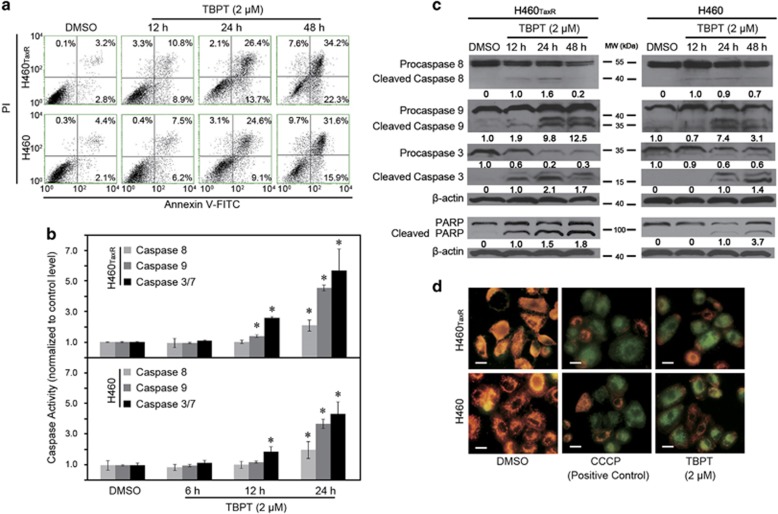
TBPT induces time-dependent apoptosis in both H460TaxR and H460 cells. (a) The cells were treated with DMSO or TBPT (2 μM), stained with PI/Annexin V-FITC, and analyzed using flow cytometry. (b) The activities of caspases 8, 9 and 3/7 were examined using a fluorescence-based assay. *Student's t-test with the DMSO group, P<0.05, N=3. (c) Western blot analysis of caspases 8, 9, 3 and PARP after TBPT treatment in NSCLC cells. (d) The mitochondrial membrane potential was determined using JC-1 dye, and a well-known mitochondrial uncoupler, CCCP, was used as a positive control. Scale bar, 20 μm. Healthy cells maintain a high mitochondrial membrane potential and emit red fluorescence, whereas apoptotic cells have a low mitochondrial membrane potential and emit green fluorescence. The mitochondrial membrane potential decreased significantly in NSCLC cells treated with TBPT